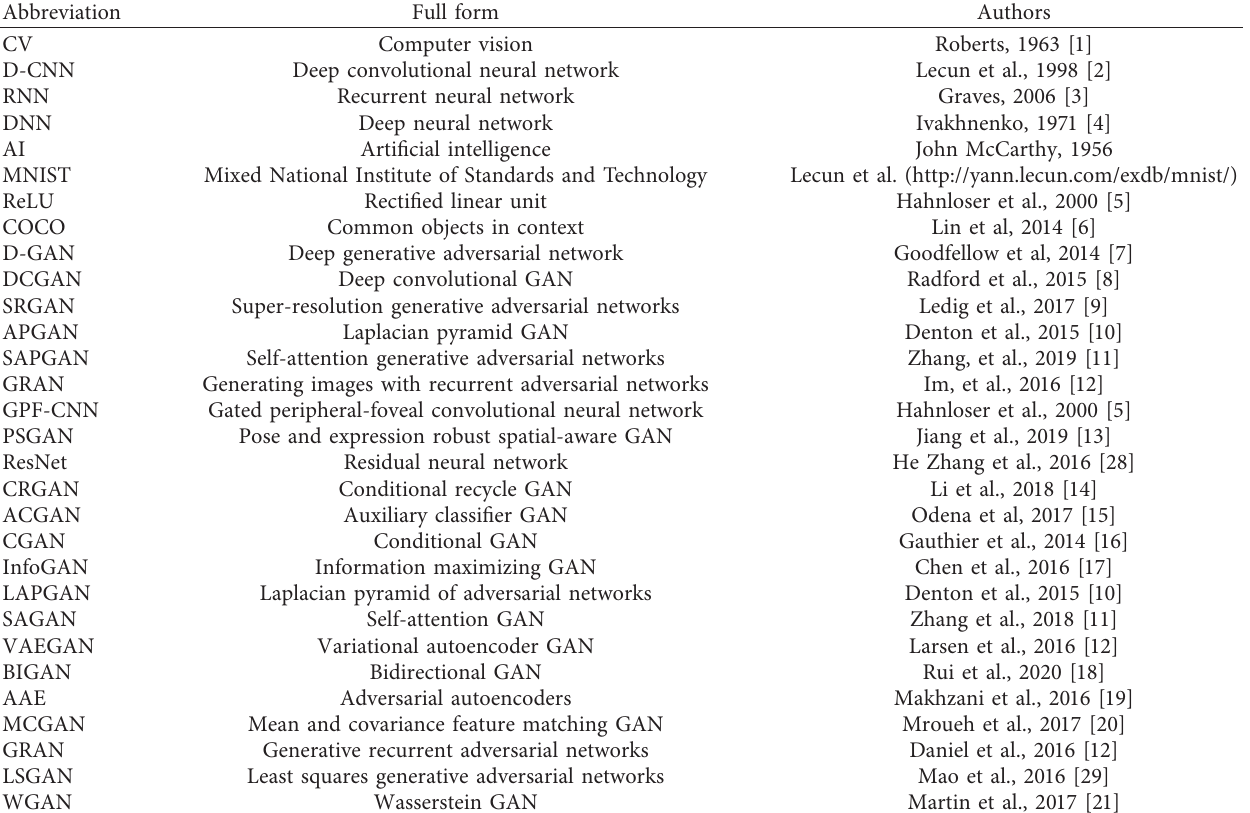
Table 1: List of abbreviations used in this manuscript along with their